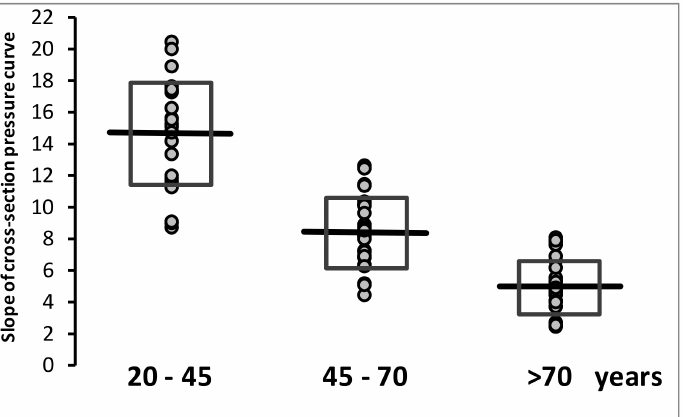
Figure 4. Slope of the cross-section diameter–pressure curves are separately shown for the different age tertiles. Mean values and standard deviation (open rectangles) are shown.